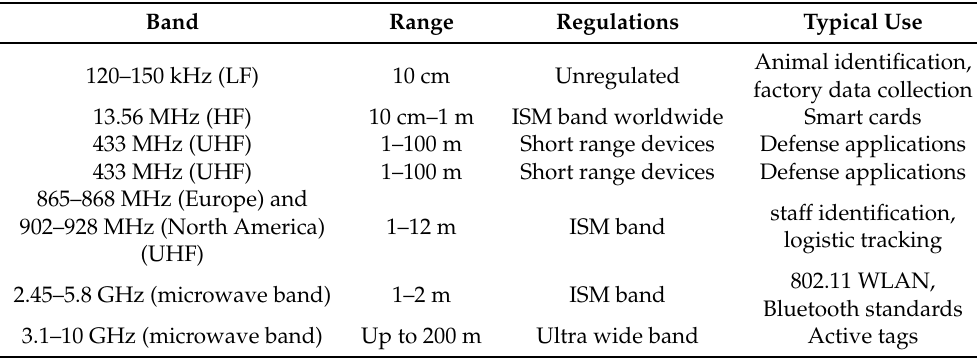
Table 1. RFID operating